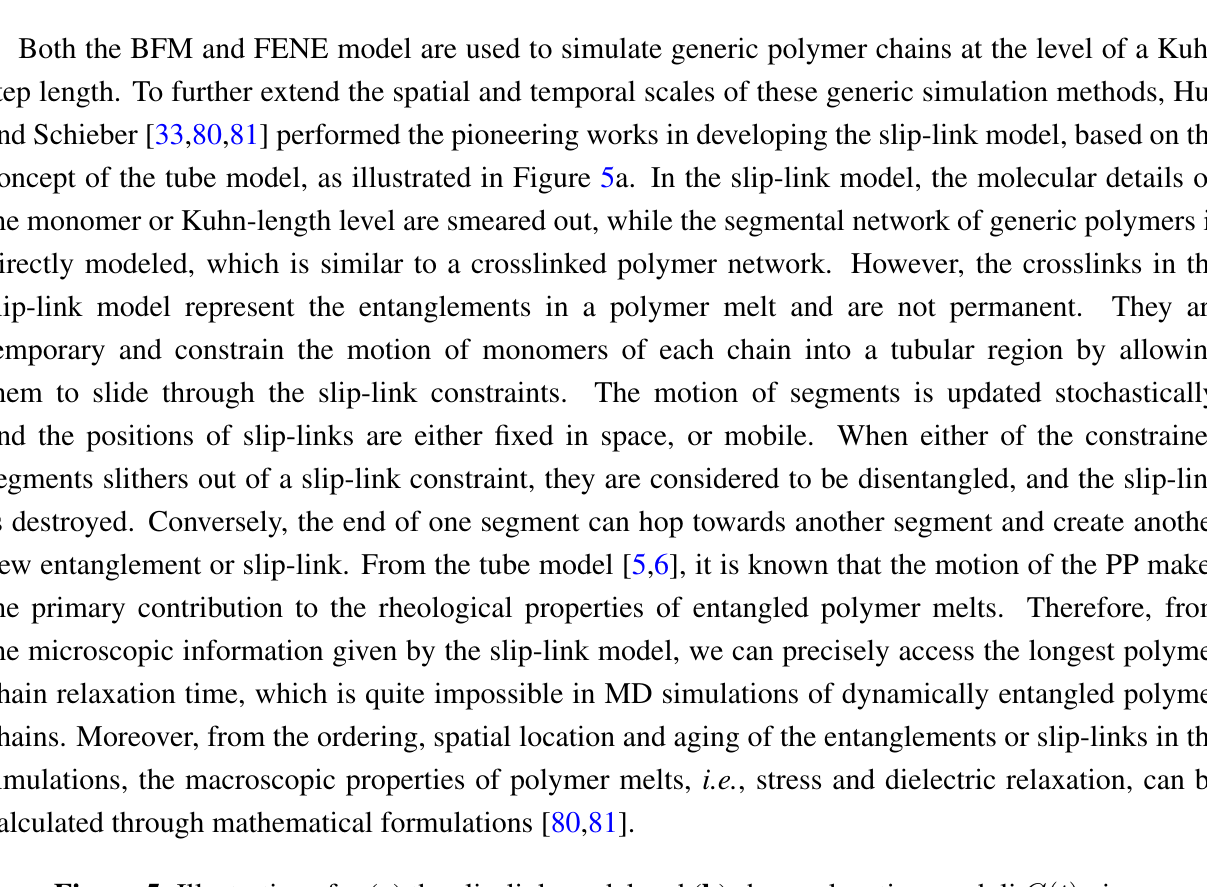
Figure 5. Illustrations for ( a ) the slip-link model and ( b ) shear relaxation moduli G ( t ) given by different models. Figures reproduced with permission from